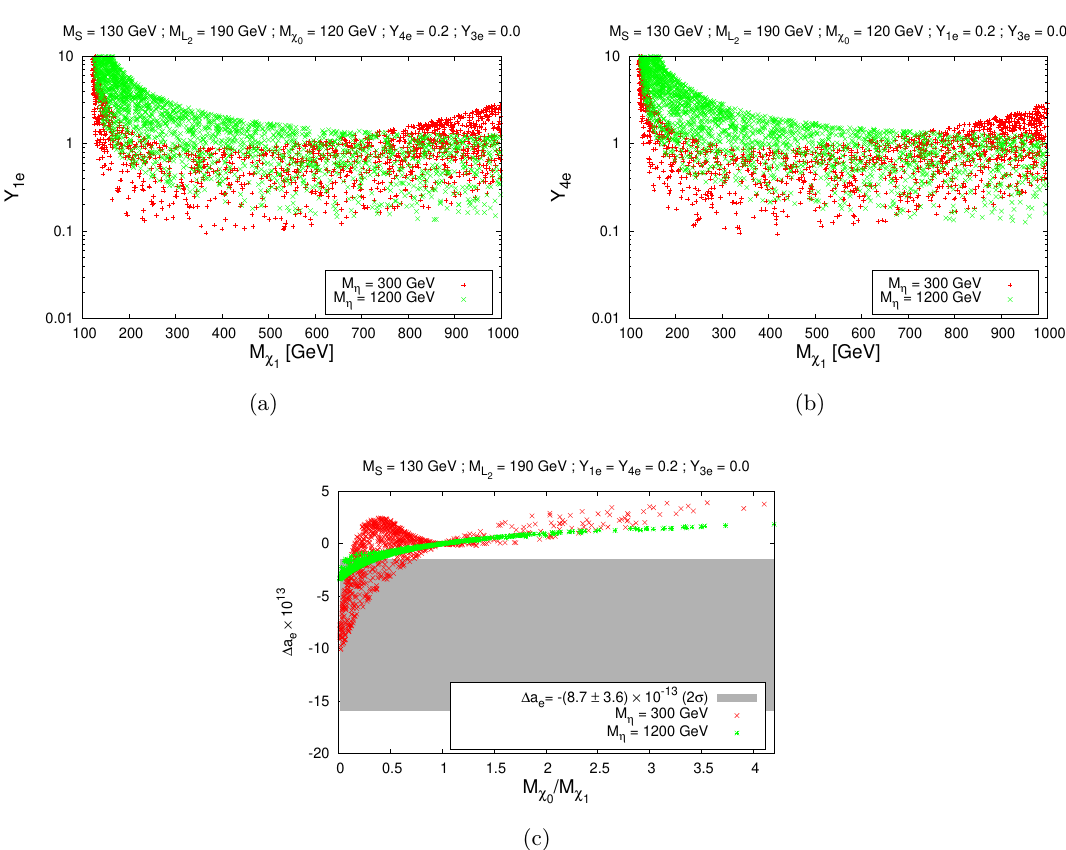
Figure 5 . Allowed parameter space satisfying ∆ a e within 2 σ bound. As before sin θ = 0 . 01 is taken. Here, red and green dots represent the scenarios corresponding to M 1200 GeV